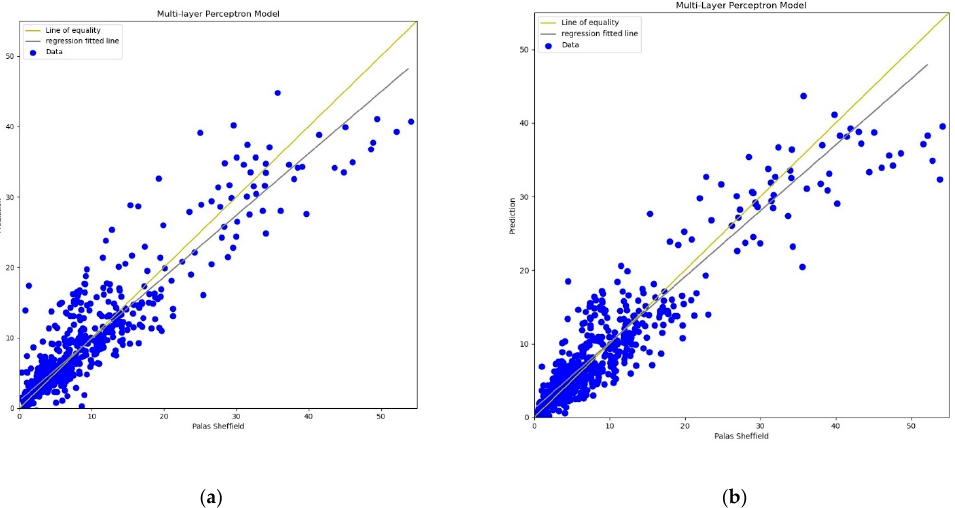
Figure 10. ( a ) MLP calibration scatter plot for PM 2.5 with the line of equality, regression fitted line, and the calibrated data using AH ; ( b ) MLP calibration scatter plot for PM 2.5 with the line of equality, regression fitted line, and the calibrated data using RH .